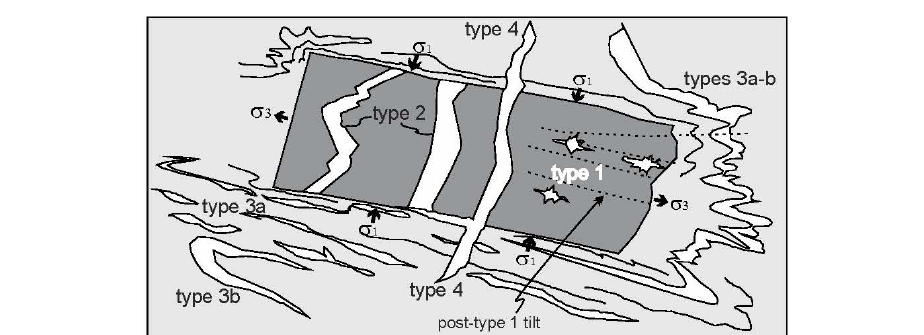
Figure 5. Schematic representation of the relationships between amphibolite boudins, the various generations of pegmatites and the main